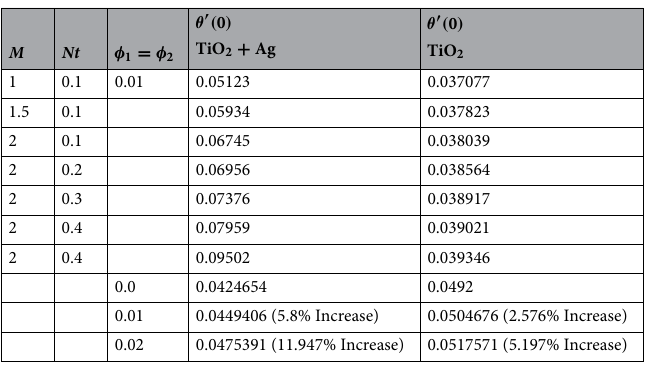
21, A 0.9, using the % formula = =